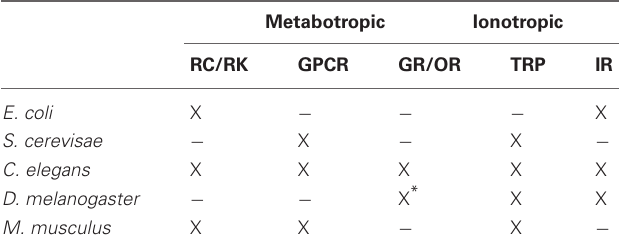
Table 1 | Chemoreceptors in model organisms operating via a metabotropic or an ionotropic